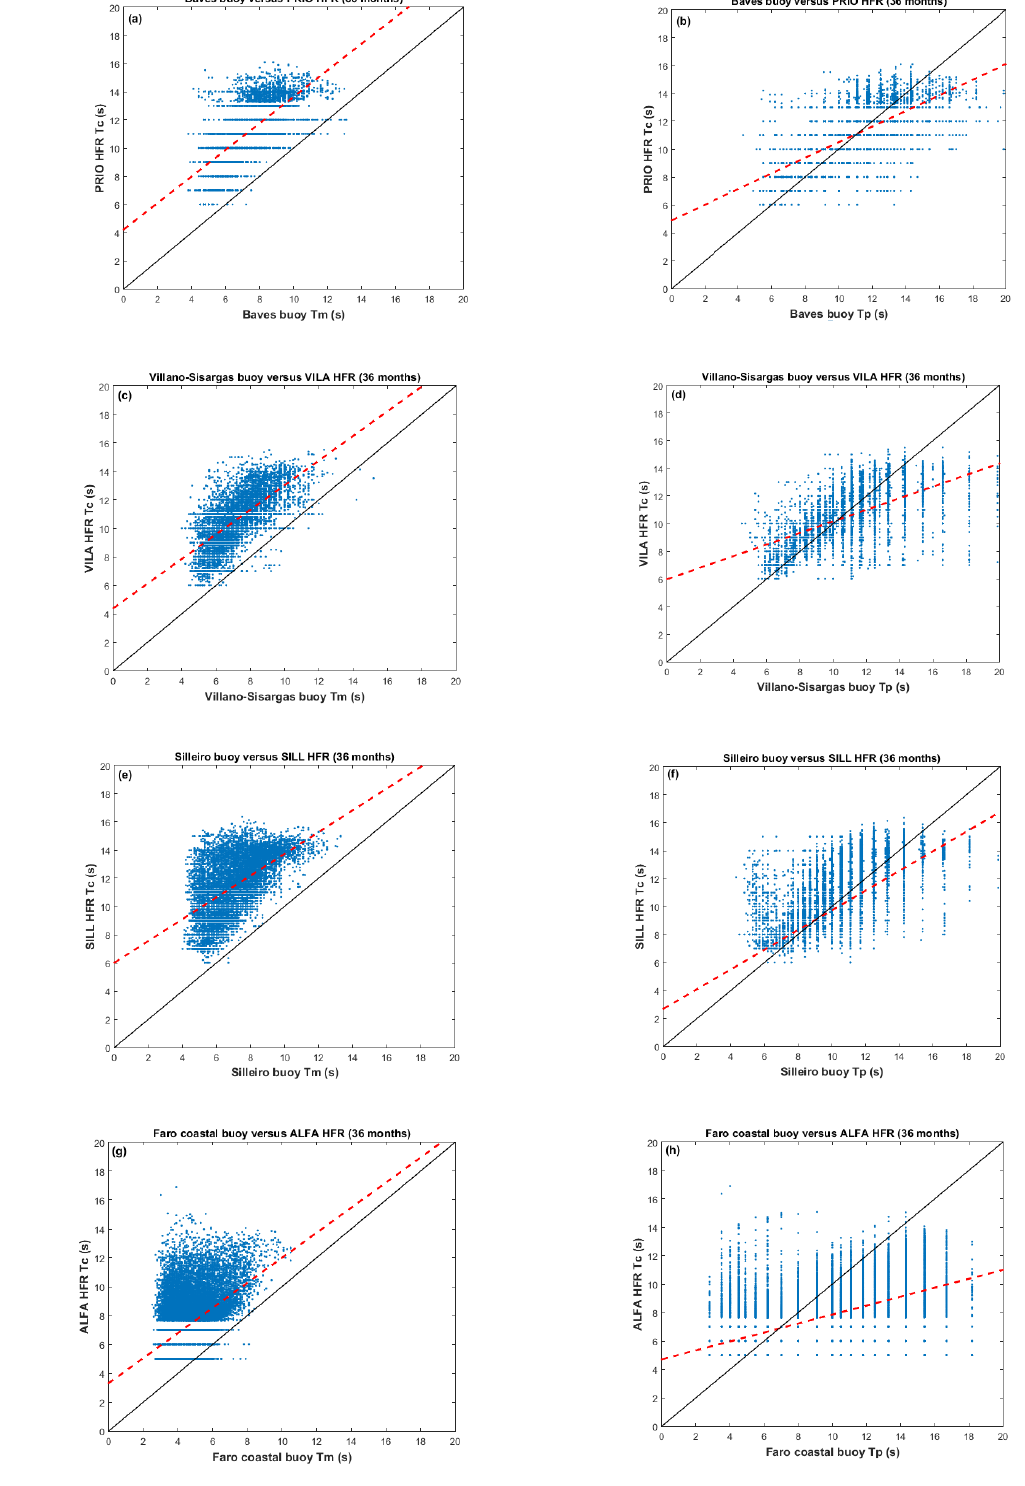
Figure A3. Wave period scatter plots. Correlations between Tc (HFR) and buoy wave periods (Tm and Tp). ( a ) PRIO Tc / Baves Tm; ( b ) PRIO Tc / Baves Tp; ( c ) VILA Tc / Villano Tm; ( d ) VILA Tc / Villano Tp; ( e ) SILL Tc / SilleiroTm; ( f ) SILL Tc / SilleiroTp; ( g ) ALFA Tc / Faro Tm and ( h ) ALFA Tc / Faro Tp.